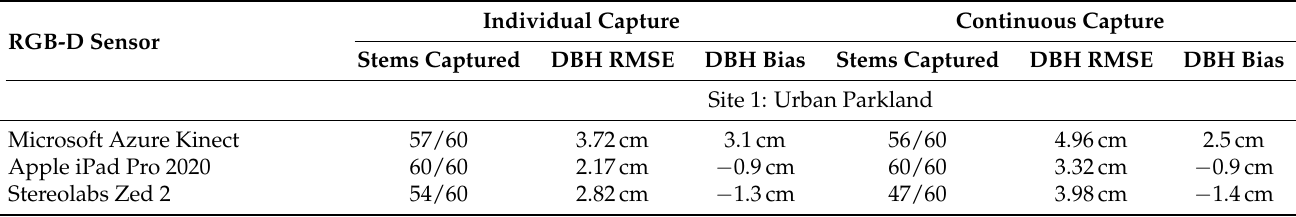
Table 2. The number of stems successfully represented, and the root-mean-square error (RMSE) and bias of the stem diameter at breast height (DBH), for the colour and depth (RGB-D) devices at both site 1 (S1) and site 2 (S2). The * symbol denotes that some stems were unable to be captured beyond a point within the plot, due to loss of positional estimate within the SLAM spatial mapping